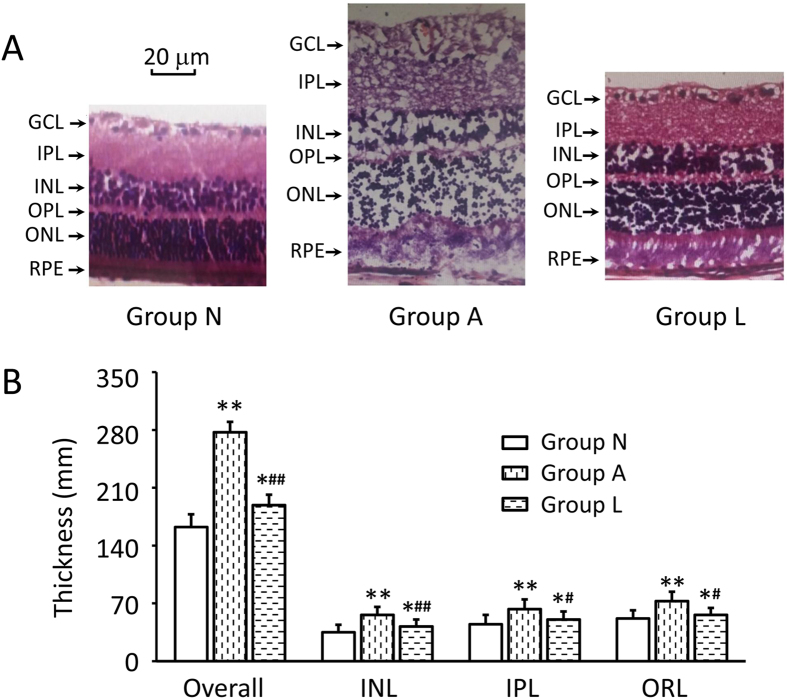
Histopathologic examination of the whole retina.(A) Representative photographs of rat retinas section from the three groups 10 days after injection. (B) Changes of the retinal thickness of each layer. In Group N, the GCL and INL were obvious and well organized. The INL in Group A was obviously thinner, and the number of GCL cells was significantly decreased, while in Group L, the retina was mildly edematous with a thicker INL as compared with Group N. GCL, ganglion cell layer; INL, inner nuclear layer; IPL, inner plexiform layer; OPL, outer plexiform layer; ONL, outer nuclear layer. Data are expressed as the mean ± SD (n = 6). *P < 0.05, **P < 0.01, vs. Group N; #P < 0.05, ##P < 0.01, vs. Group A. Scale bar = 20 mm.